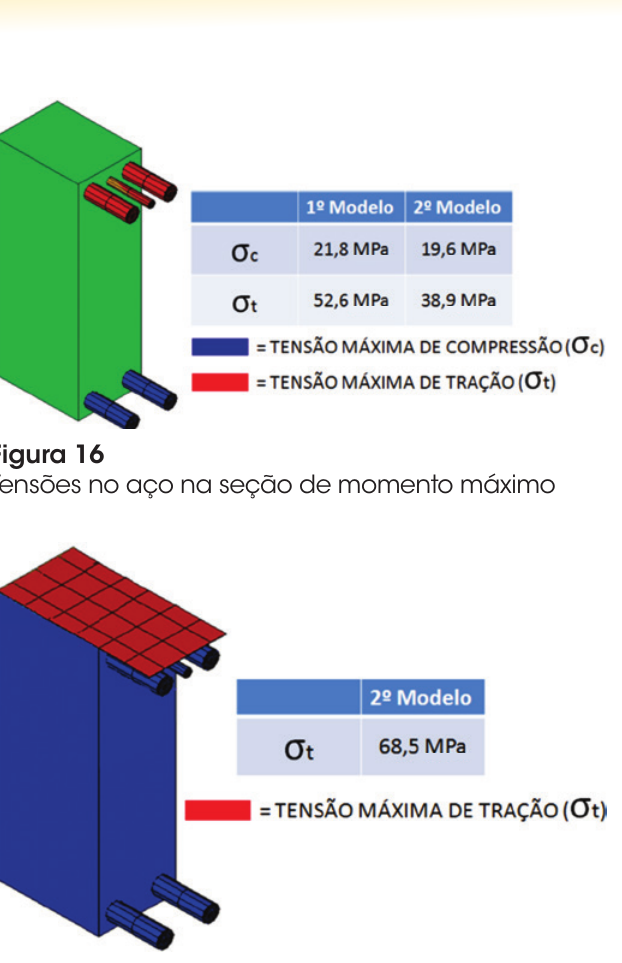
As regiões em vermelho representam os pontos de fissuras (“ cra- cks ”) na região tracionada e esmagamento do concreto (“ crushing ”) na região comprimida. As regiões A e B identificadas na Figura 10 está detalhada, para cada modelo, na Figura 11. Para o Modelo 1, onde não houve reforço à flexão, observa-se que vam que a resistência à tração na flexão do concreto foi atingida.